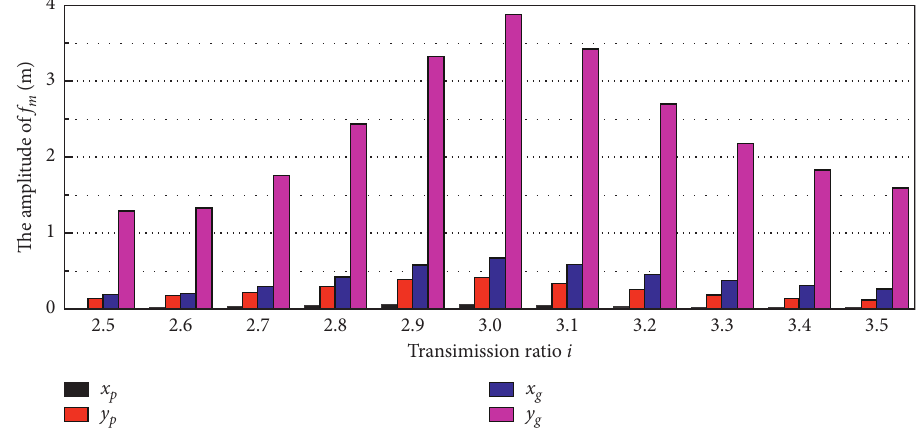
Figure 10: The amplitude of the meshing frequency f